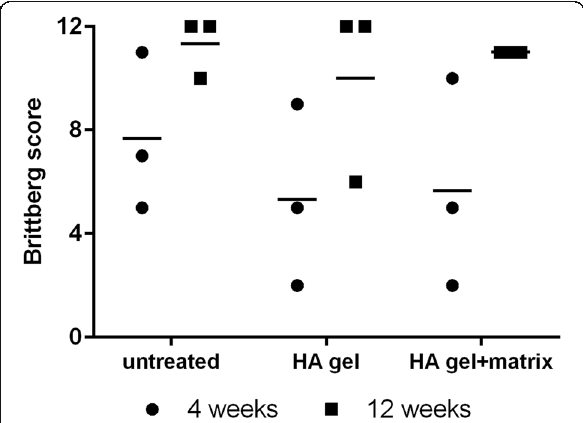
Fig. 1 Macroscopic repair score of the regenerated tissue. Individual scores are represented as dots (4 weeks) and squares (12 weeks) with the arithmetic means of the untreated and treated groups shown as horizontal bars . The scores (1 – 12) represent the overall repair by assessing the initially grafted surface, integration to border zone and macroscopic appearance. No significant (n.s.) difference within a group or between the three groups is given in the two